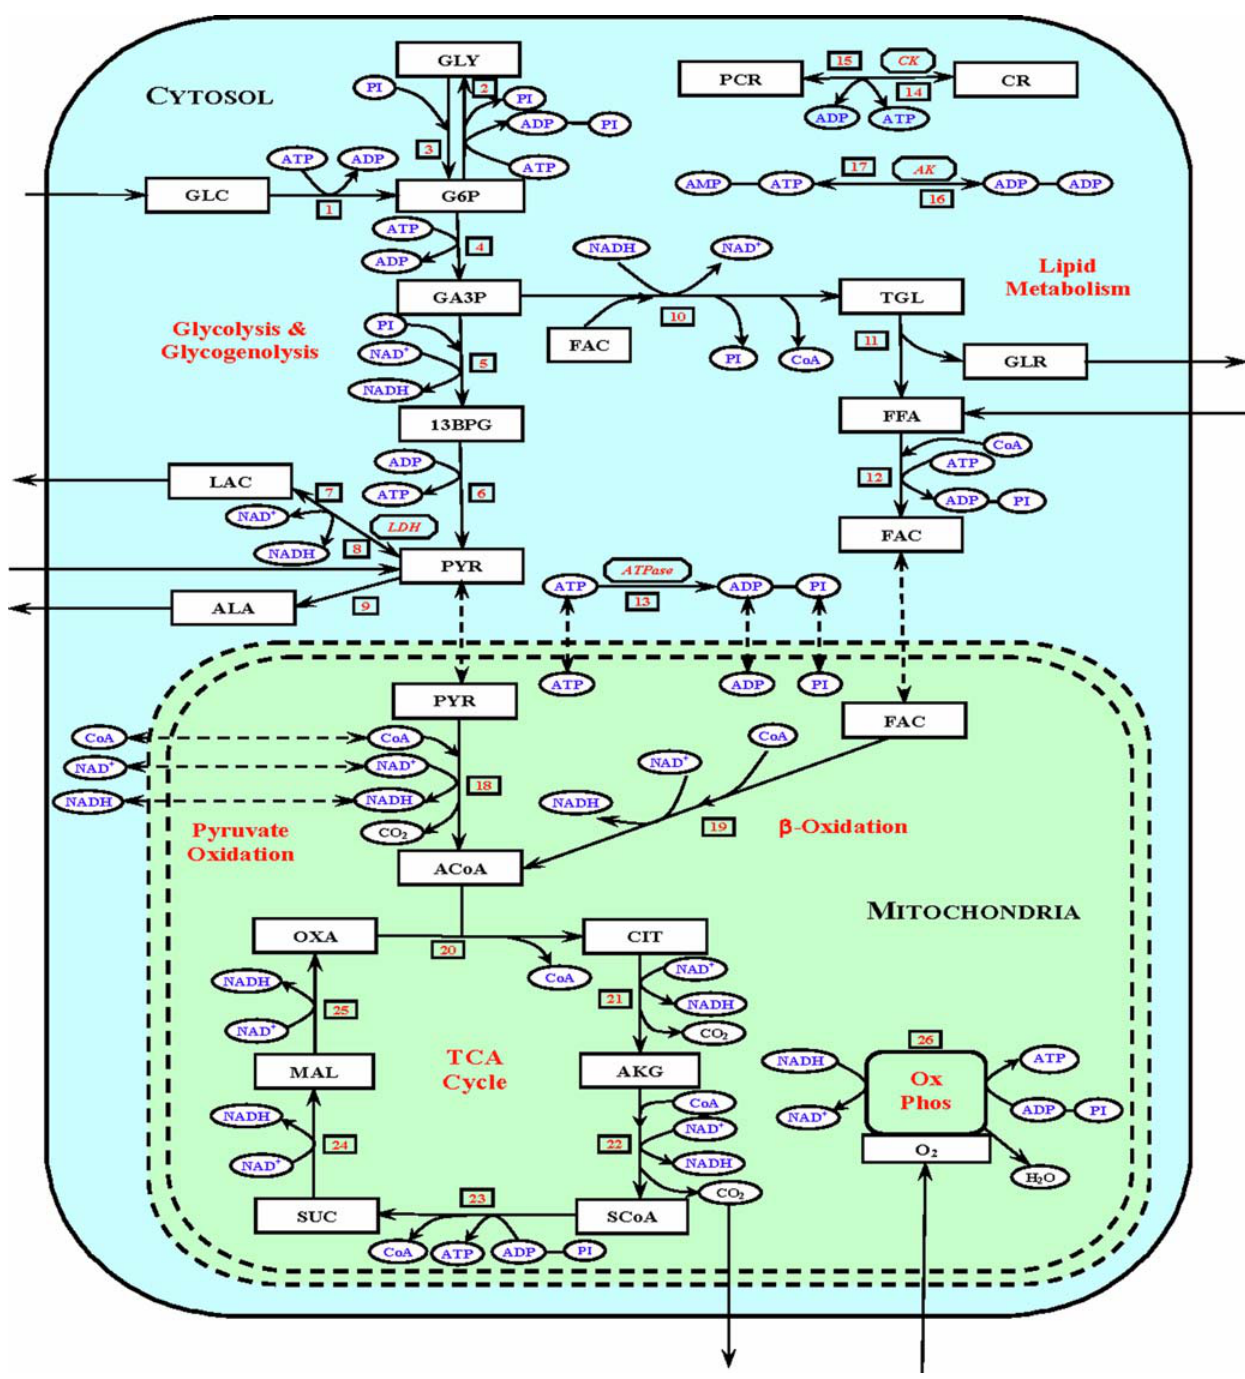
Figure 1. Schematic diagram of biochemical pathways depicting various chemical reactions and species involved in the cellular metabolism of skeletal muscle. The pathways involve 26 lumped reactions among 30 species out of which 8 species (GLC, LAC, PYR, ALA, FFA, GLR, CO 2 and O 2 ) undergo blood-tissue cells exchange. The exchange arrows show the direction of net tissue cells uptake-release rates at normal, resting conditions. The lumped reactions are further compartmentalized into the cytosolic and mitochondrial reactions. These two subcellular domains are assumed to be in rapid equilibrium state (the barrier is shown schematically by double dotted lines), so that the species that are common to both these domains can have the similar dynamics, i.e., C mit,j ( t )= s j .C cyt,j ( t ), where s j is the partition coefficient of the species j between cytosol and mitochondria. In this case, the net transport flux of a species j across the cytosol-mitochondria barrier can quickly become negligible at the onset of a physiological perturbation (the transport fluxes are shown by double dotted arrows); 10 species (PYR, FAC, CoA, NADH, NAD + , ATP, ADP, PI, CO 2 and O 2 ) exist in both the cytosolic and mitochondrial domains. GLC: glucose, GLY: glycogen, G6P: glucose-6-phosphate, GA3P: glyceraldehyde-3-phosphate, 13BPG: 1,3-biphosphate-glycerate, PYR: pyruvate, LAC: lactate, ALA: alanine, TGL: triglycerides, GLR: glycerol, FFA: free fatty acid, FAC: fatty acyl-CoA, ACoA: acetyl-CoA, CIT: citrate, AKG: a -ketogluterate, SCoA: succinyl-CoA, SUC: succinate, MAL: malate, OXA: oxaloacetate, CoA: coenzyme-A (free), PCR: phosphocreatine, CR: creatine, PI: inorganic phosphate, CO 2 : carbon dioxide, O 2 : oxygen, NADH: reduced